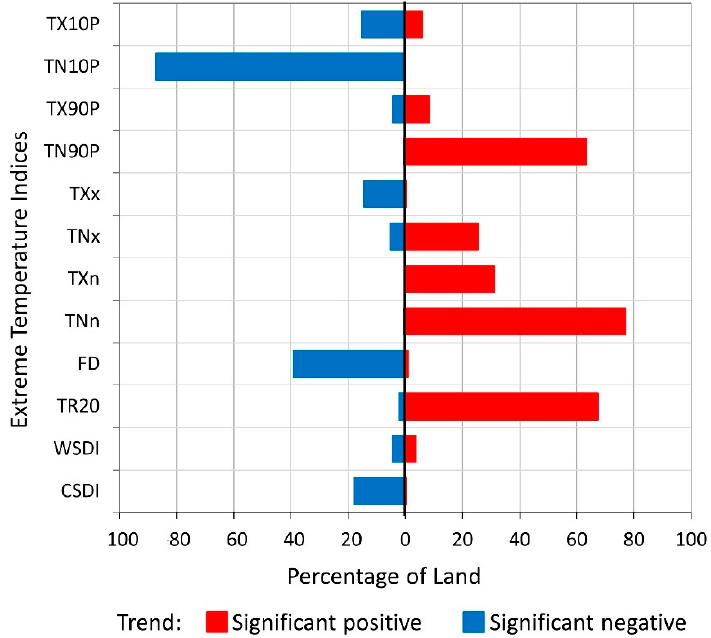
Figure 4. Percentage of positive and negative trends that are significant at the 5% level for all temperature extreme indices.